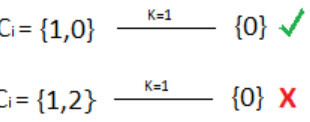
Figure 6: Classification of the instances with imprecise